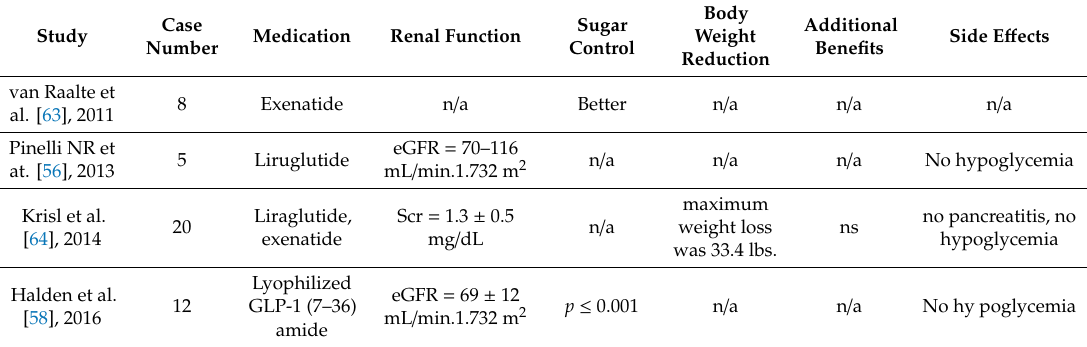
Table 1. All published studies regarding recipients using